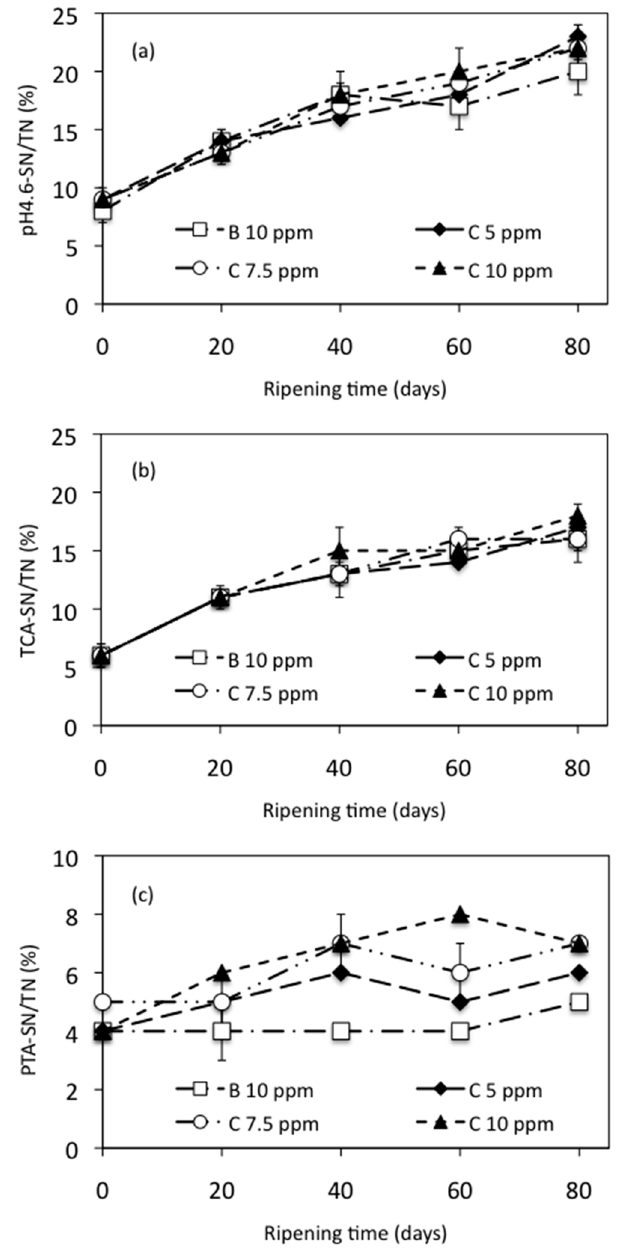
Figure 3. Proteolysis of manchego-style cheeses ripened at 10 °C, expressed as ( a ) soluble nitrogen (SN) at pH 4.6 (pH 4.6-SN)/total nitrogen (TN), ( b ) in trichloroacetic acid (TCA-SN)/TN and ( c ) in phosphotungstic acid (PTA-SN)/TN. B = bixin, C = curcumin.